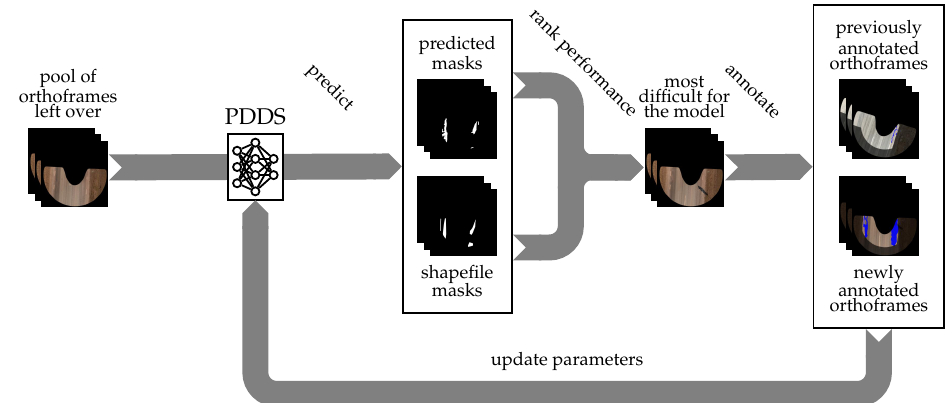
Figure 13. Active learning of road contours and pavement